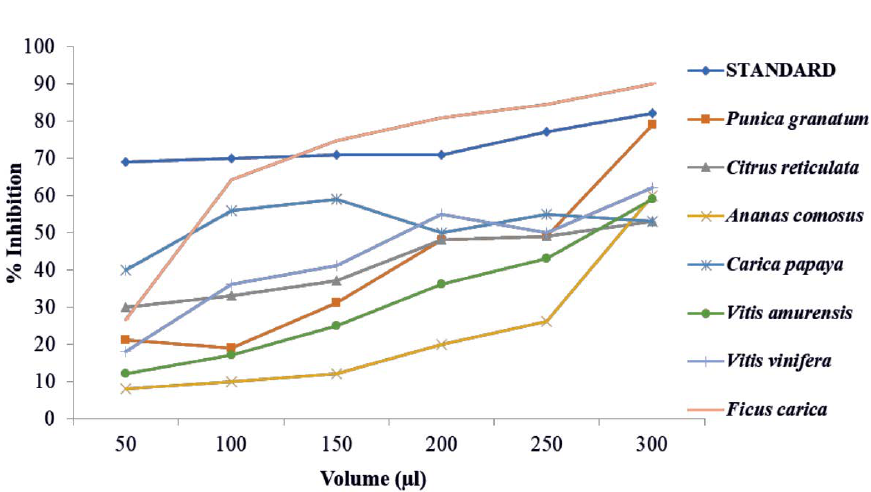
Fig. 2. Antioxidant Activity by DPPH assay